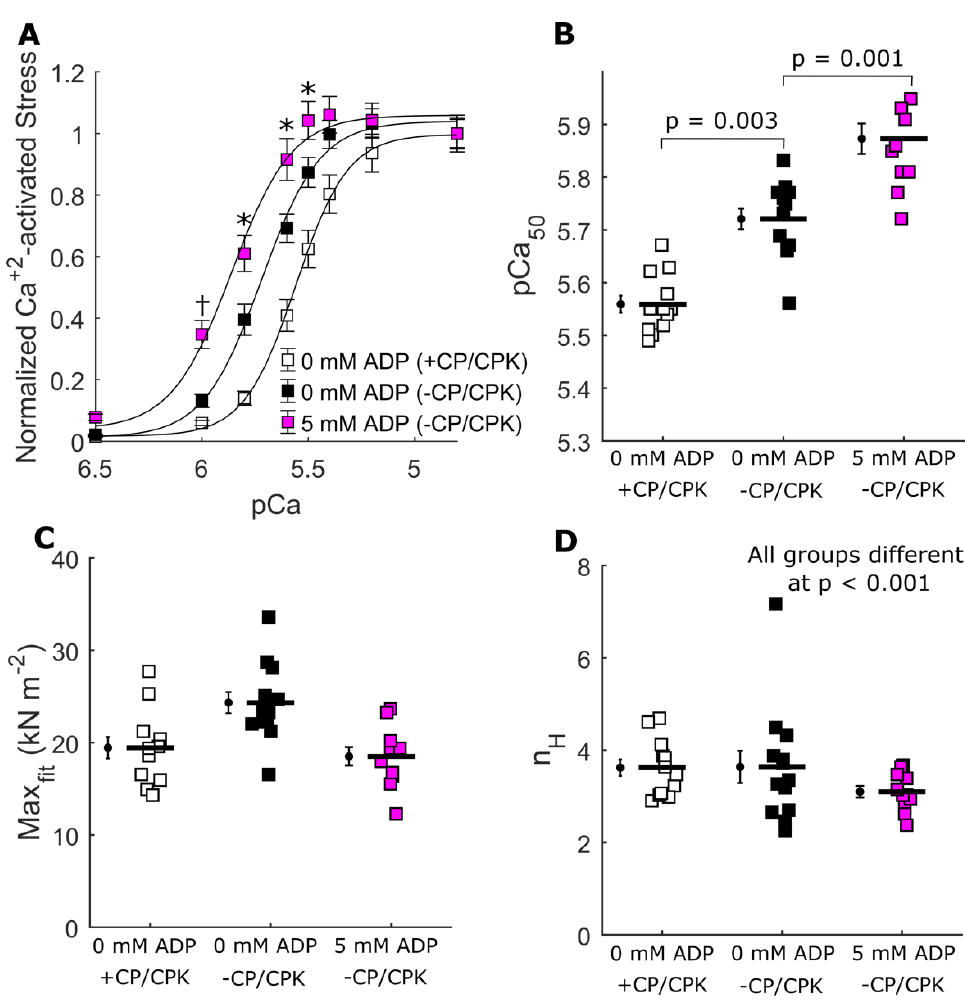
Figure 6. Ca 2+ -activated tension-pCa relationships. Steady-state isometric stress plotted against pCa, showing the increase in force from relaxing conditions at pCa 8.0 as strips were titrated to pCa 4.8. ( A ) Effects of [ADP] on Ca 2+ -activated force in the absence of CP and CPK, compared to control strips (=0 mM [ADP], +CP/CPK). Data were fit to a 3-parameter Hill equation, with parameters shown for ( B ) maximal Ca 2+ -activated stress (Max fit ), ( C ) Hill coefficient (n H ), and ( D ) calcium sensitivity(pCa 50 ). Nested two-way linear mixed models analyses were used to characterize main effects of pCa and treatment group ([ADP] − /+ CPK). In Panel A, there was a significant main effect of pCa ( p < 0.001), treatment group ( p < 0.001), and a pCa* treatment group interaction ( p < 0.001) were observed, with * indicating a Fisher’s LSD post hoc difference between all treatment groups at a single pCa ( p < 0.05). † indicates a Fisher’s LSD post hoc difference between the treatment group of 5 mM ADP without CP/CPK and all other treatment groups at a single pCa ( p < 0.05). Nested one-way linear mixed models were utilized to characterize the main effect of treatment group ([ADP] − /+ CPK) in Panels B, C, and D. This analysis showed a significant main effect of treatment group in panels B ( p = 0.03), C ( p = 0.03) and D ( p < 0.001), with the p -values listed in each panel indicating Fisher’s LSD post hoc differences between groups. n fibers were 13 for 0 mM ADP (+CP/CPK), 12 for 0 mM ADP (+CP/CPK), and 11 for 5 mM ADP (+CP/CPK), from 2 hearts. Small-amplitude sinusoidal length-perturbations were used to measure the viscoelas- ticity of these strips under Ca 2+ -activated conditions (Figure 7). Frequency-dependent shifts in the dips and peaks of the moduli-frequency relationships illustrate changes in the overall cross-bridge cycling rate. The fastest cross-bridge cycling occurred in control strips (0 mM ADP, +CP/CPK), with the moduli-frequency relationships being shifted towards higher frequencies. Compared to these control strips, removing CP/CPK